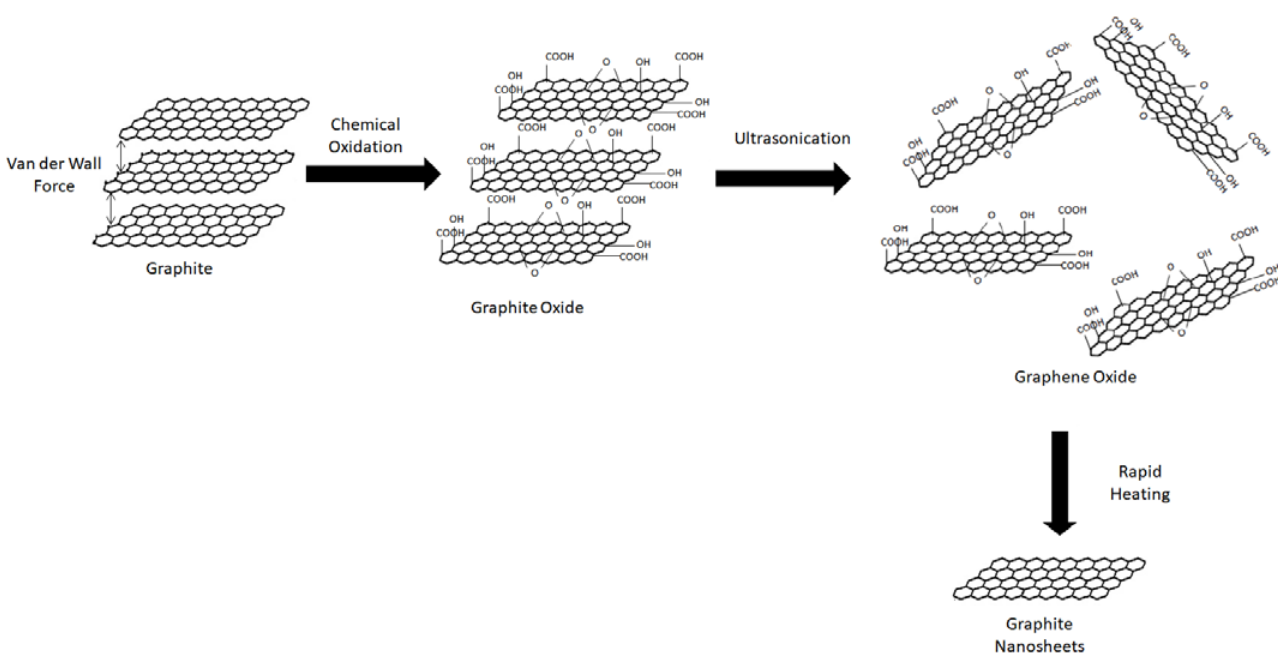
Figure 3. Chemical exfoliation of graphite to graphite nanosheets.